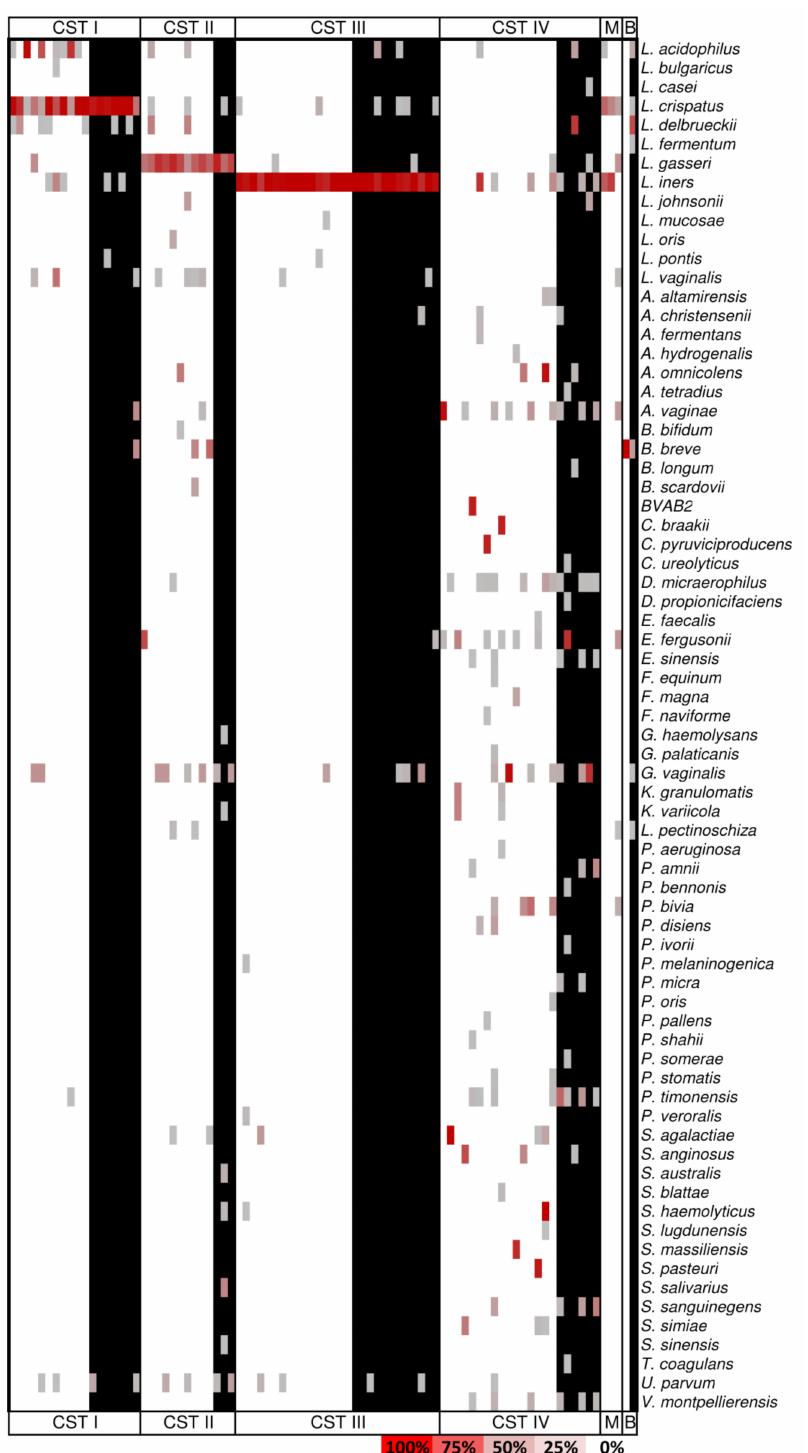
Figure 1. The microbiome composition according to the community state types (CSTs) classification. The heat map shows the relative abundances of the bacteria identified in the CSTs groups: CST I is dominated by L. crispatus , CST II by L. gasseri , CST III by L. iners , and CST IV is depleted of Lactobacilli . The relative abundances were calculated on the rarefied_otu_table.biom (5000 reads / sample) by means of the summarize_taxa.py script (QIIME 1.9.1). Within each CST, the black bars identify the viral DNA positive samples. Abbreviations: M: mixed CST; B: Bifidobacteria